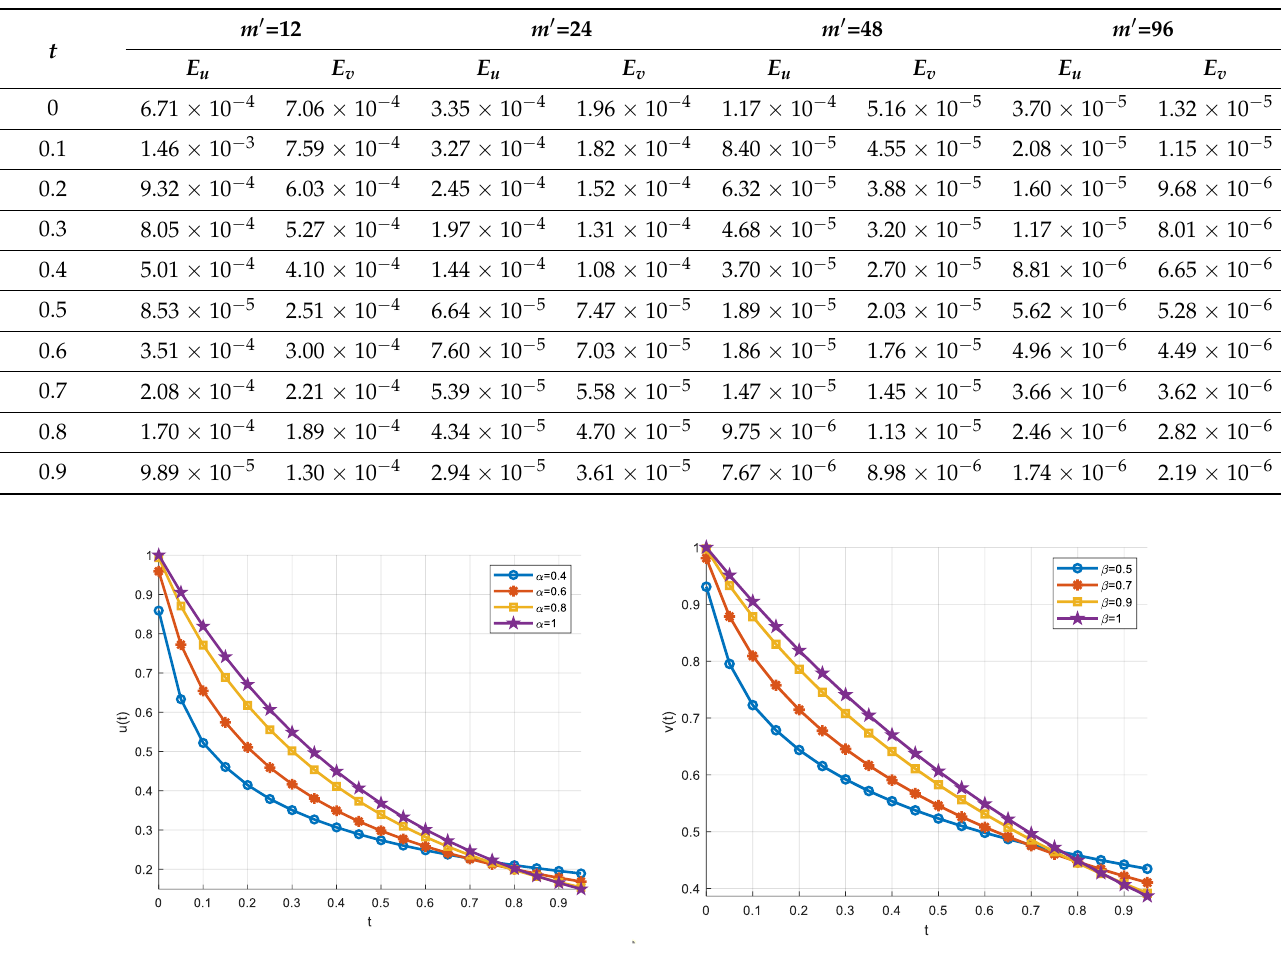
Table 2. Absolute errors E u and E v corresponding to u ( t ) and v ( t ) for several m (cid:48) values of Example 2.